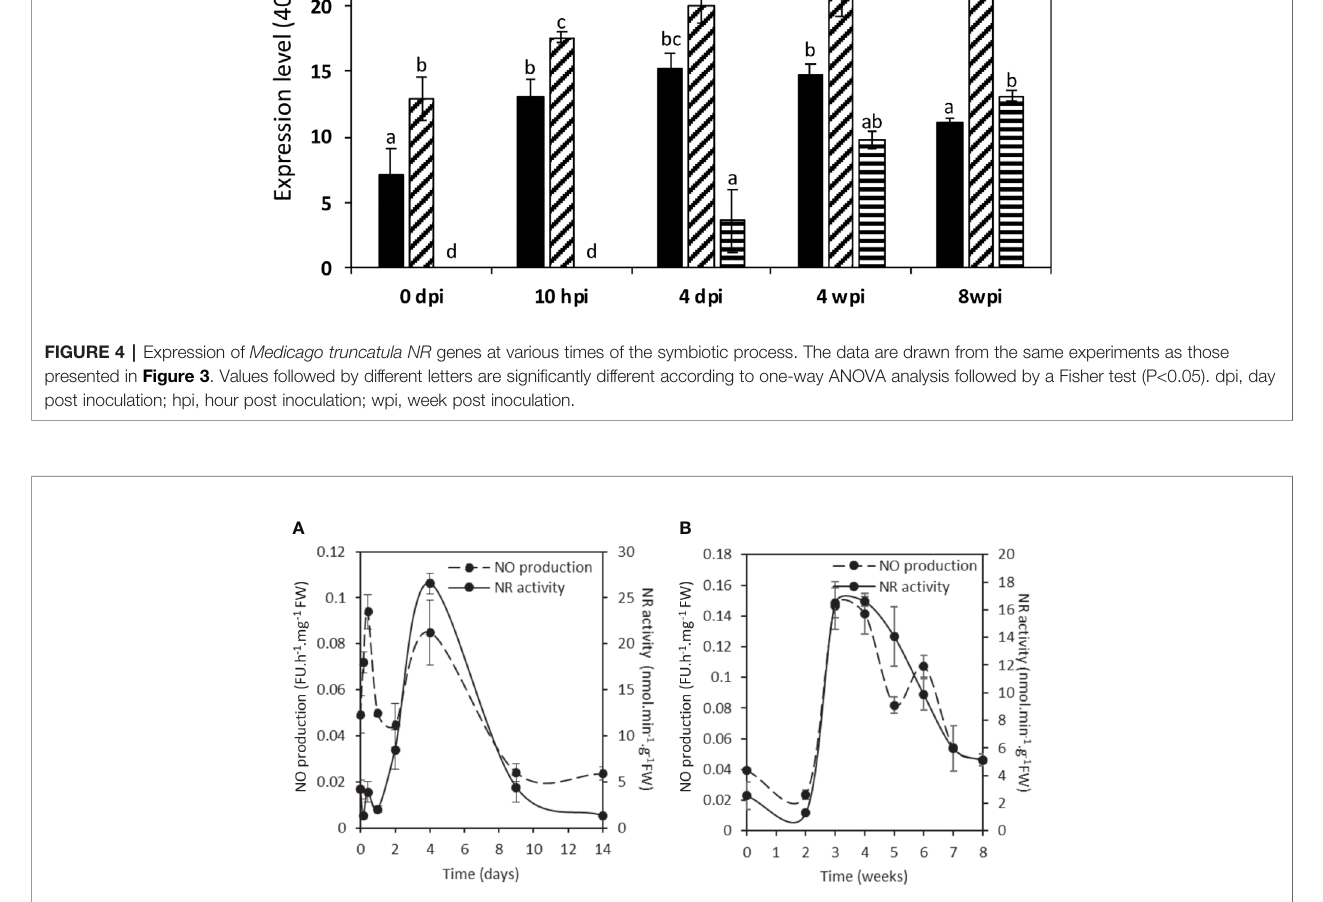
FIGURE 5 | NR activity and NO production during the Medicago truncatula symbiosis. Short term kinetic 14 dpi (A) , long term kinetic 8 wpi (B) . The nitrate reductase activity is expressed in nmol per min per g of fresh weight. The fl uorescence intensity of the NO production was measured using the DAF-2 fl uorescent probe. Data are means ± SE of three biological replicates. Each measure was realized in three technical replicates. dpi, day post inoculation; FU, fl uorescence unit; wpi, week post